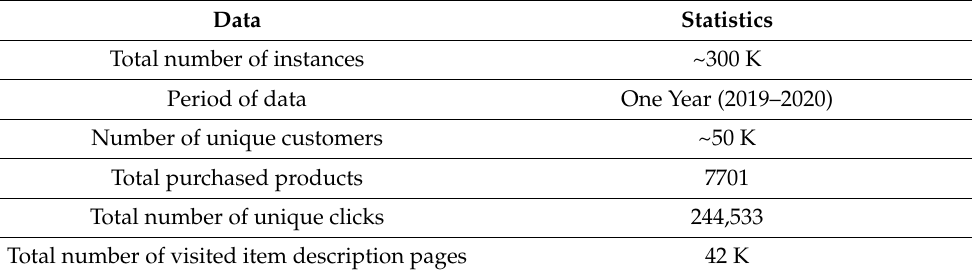
Table 3. Description of experimental